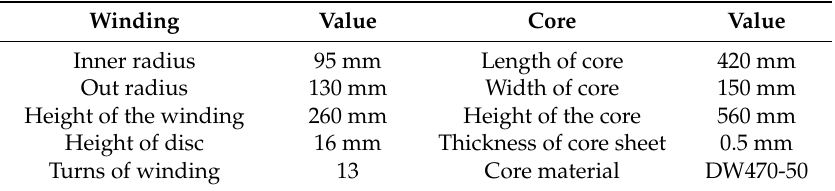
Table 1. Parameters of the transformer winding and